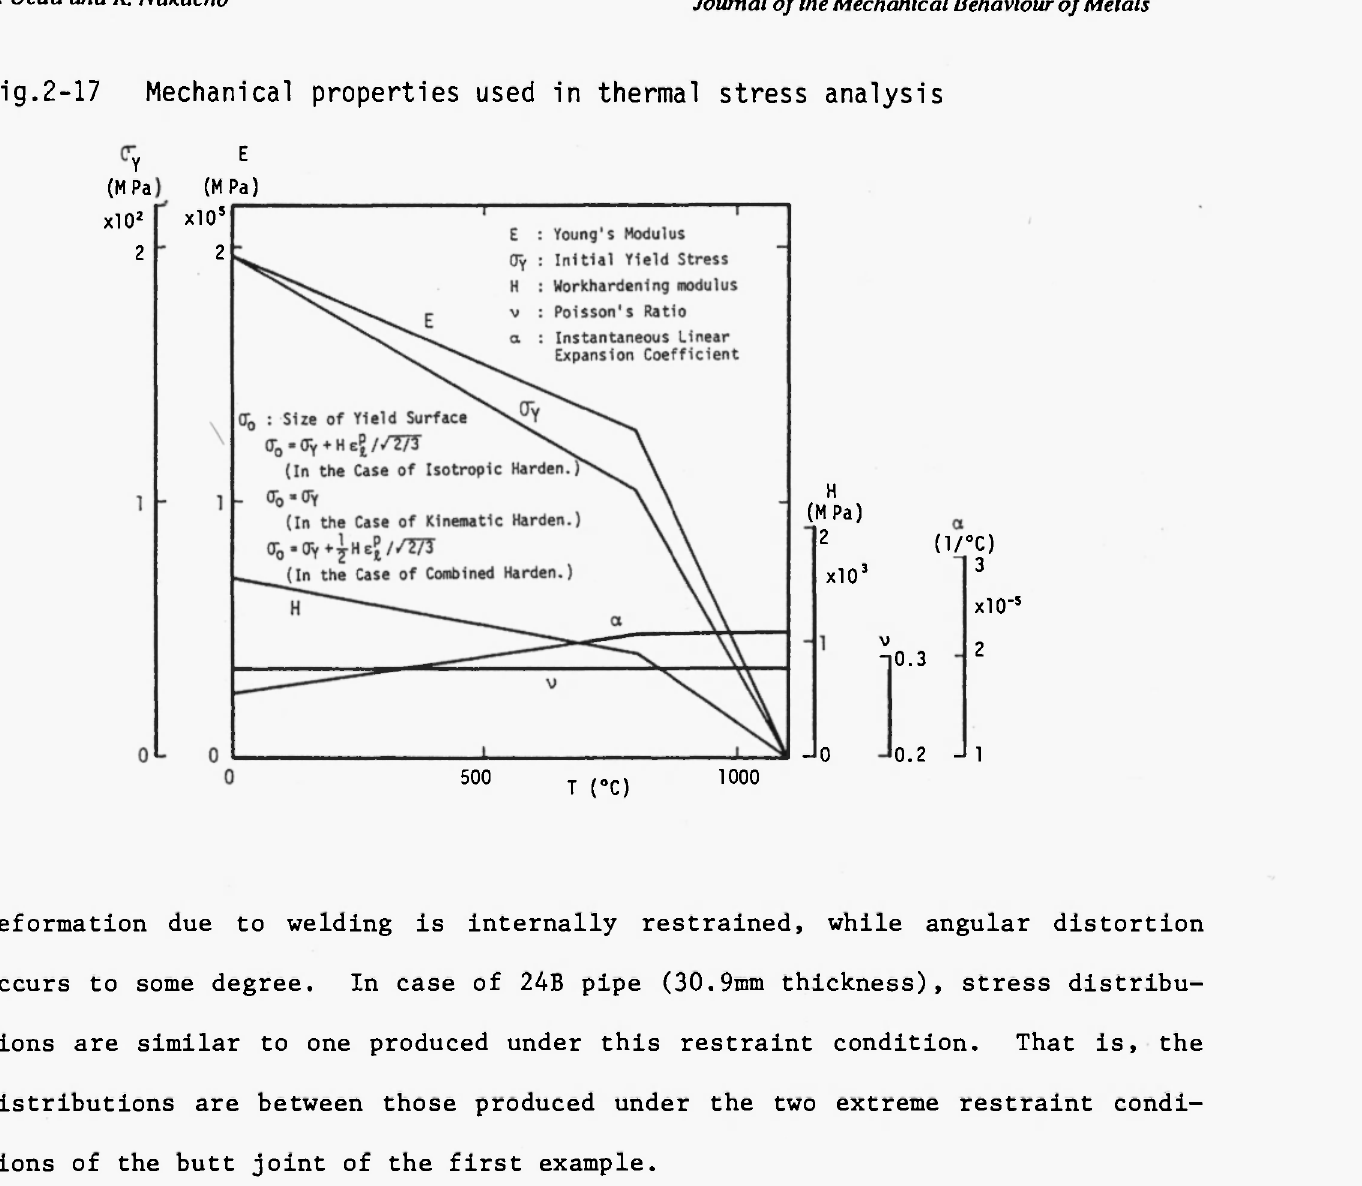
Fig.2-17 Mechanical properties used in thermal stress